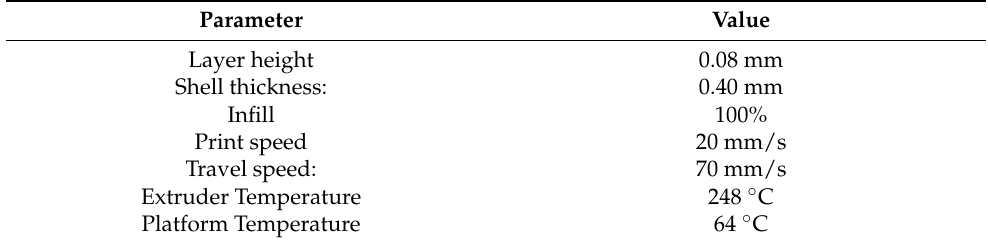
Table 2. Printing